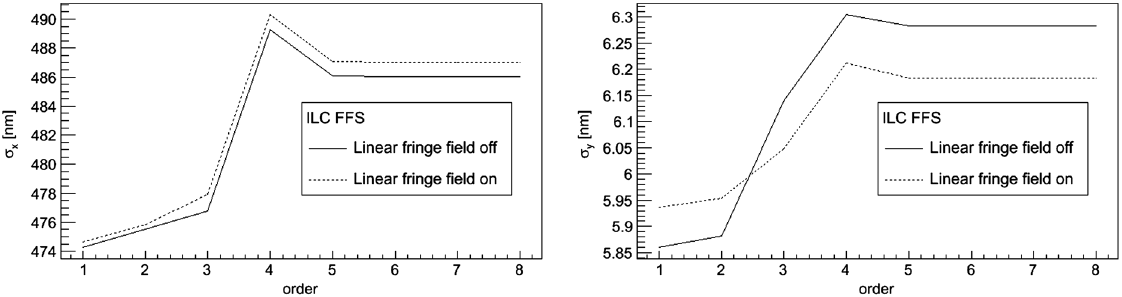
FIG. 3. Linear fringe field impact on the horizontal (left) and vertical (right) beam size in the ILC BDS lattice.